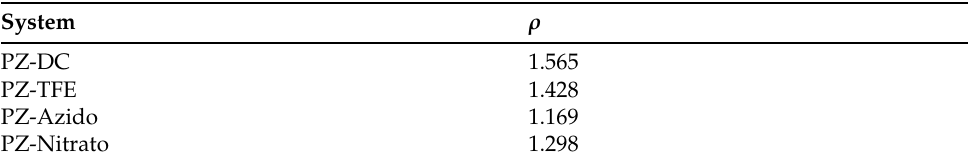
Table 1. Densities of liquid systems at 50 ◦ C in g · cm − 3